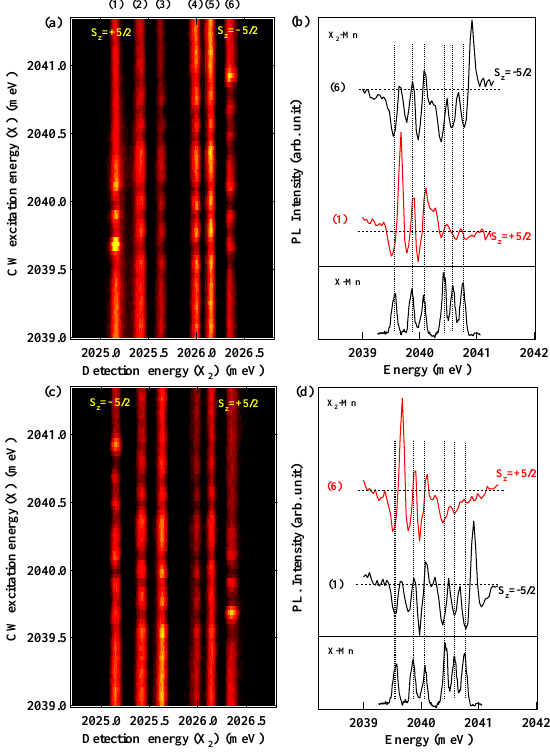
Figure 9: Map of the PL intensity of X 2 -Mn versus the energy of the CW resonant excitation on X-Mn for co (a) and cross (c) circular CW excitation and detection of X 2 -Mn. (b) and (d) present the corre- sponding intensity curves of X 2 -Mn for the spin states S z = +5/2 (1) and S z = − 5/2 (6).